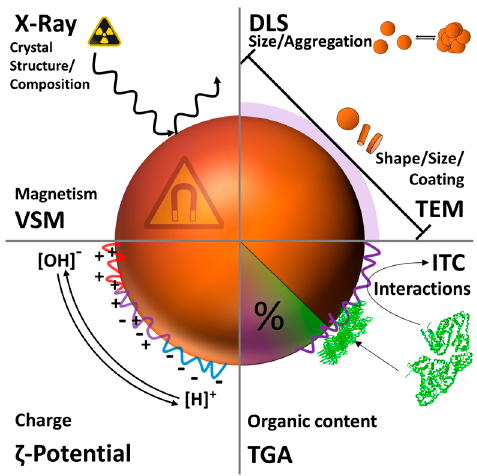
Figure 8. Schematic representation of different analysis techniques for magnetic nanoparticles and the corresponding surface modifications.